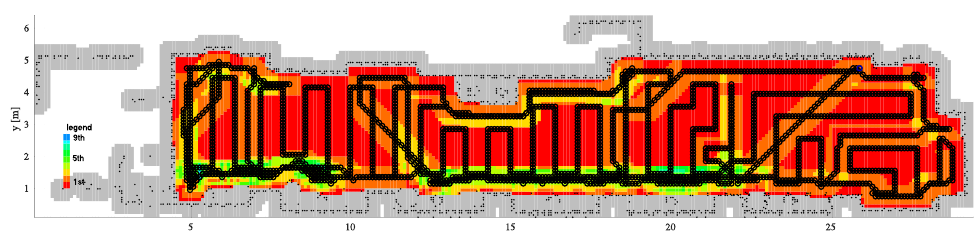
Figure 12. The complete coverage of the CCD* algorithm with the path and noted redundant numbers of cell visits (from 1 to 9).